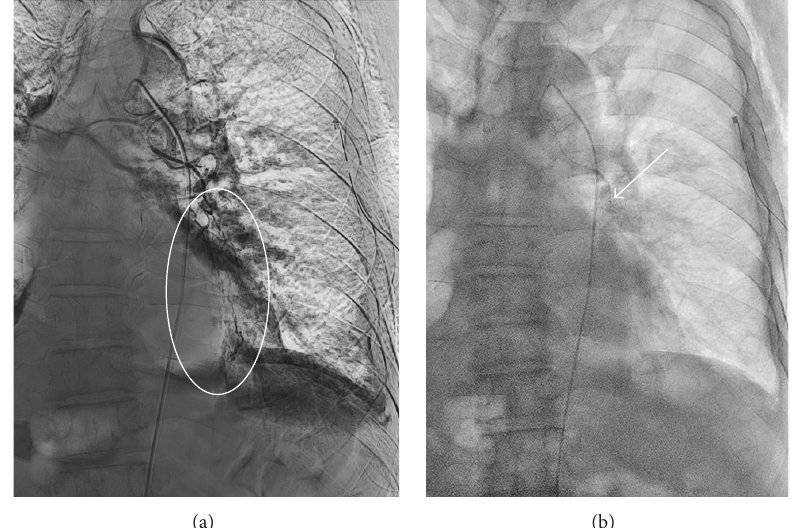
Figure 2: (a) A chest X-ray showed bleeding from the left bronchial artery in the left upper lobe (white circle). (b) A chest X-ray indicated the arrest of bleeding after bronchial artery embolization (white